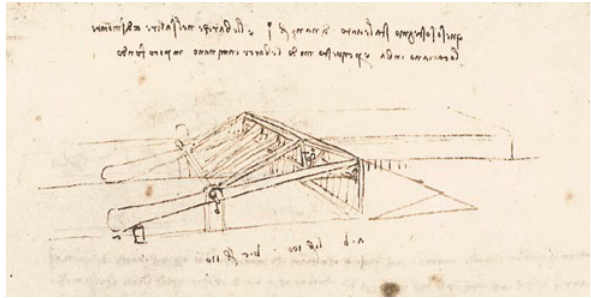
Figure 26. C.A., fol. 127v, detail: counterweight water support.